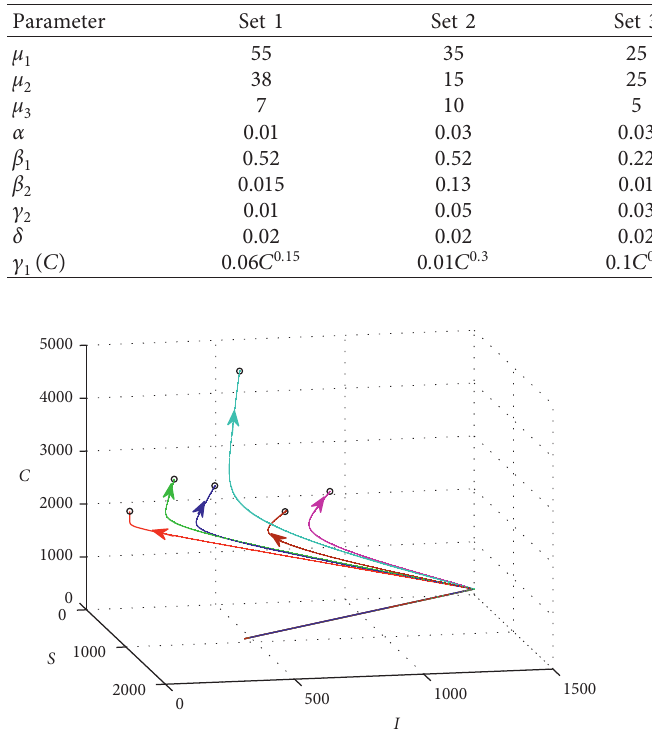
Figure 4: Six orbits of system (1) with different system parameters.